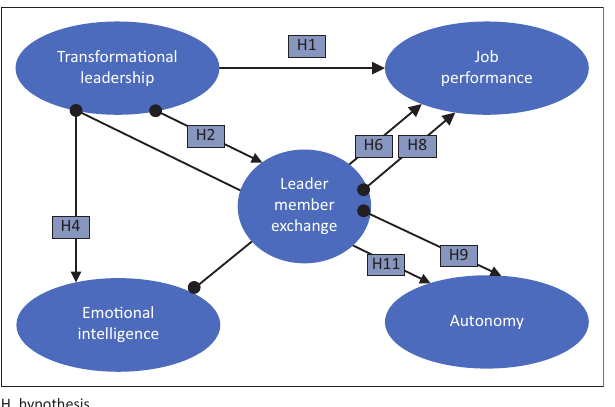
H , hypothesis. FIGURE 3: Direct effects of mediation. TABLE 5: Results from regression analyses: Direct effects. Hypothesis